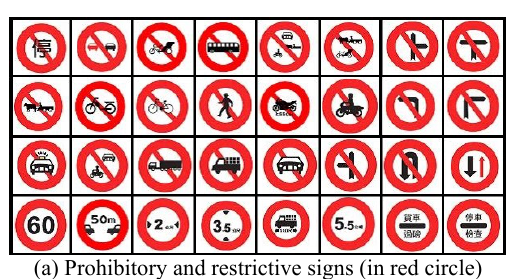
Figure 2. Normalization of extracted ROI image blocks